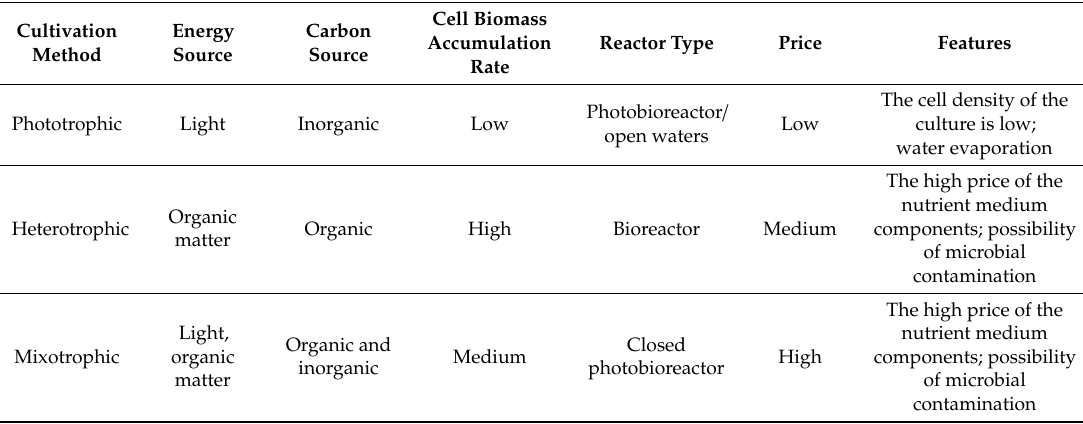
Table 6. Characteristics of possible methods for microalgae